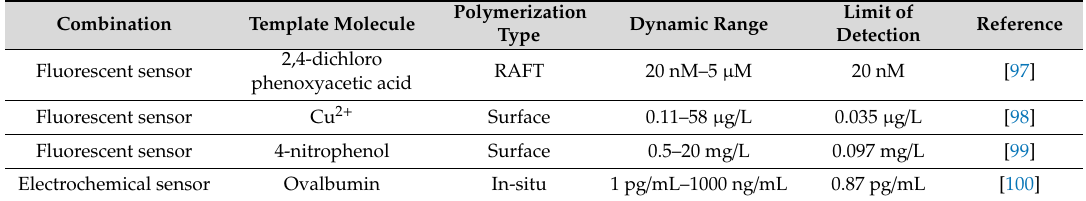
Figure 4. The preparation process of the paper-based microfluidic systems for the determination of phenolic contaminants ( a ). The indicators in the plot: a complete chip under daylight (I), image of the six test sites on the chip under UV light (II), image of the test site through the hole of the top sampling layer under UV light (III), and schematic of the entire working process of the rotational chip and an image of rotational paper-based microfluidic chips placed and the detection process in the fluorescence spectrometer (IV). The preparation steps of the system to determine glycoprotein ovalbumin ( b ). Republished with permission from Qi et al. and Sun et al. [99,100]. Table 4. Comparison of molecularly imprinted lab-on-a-chip